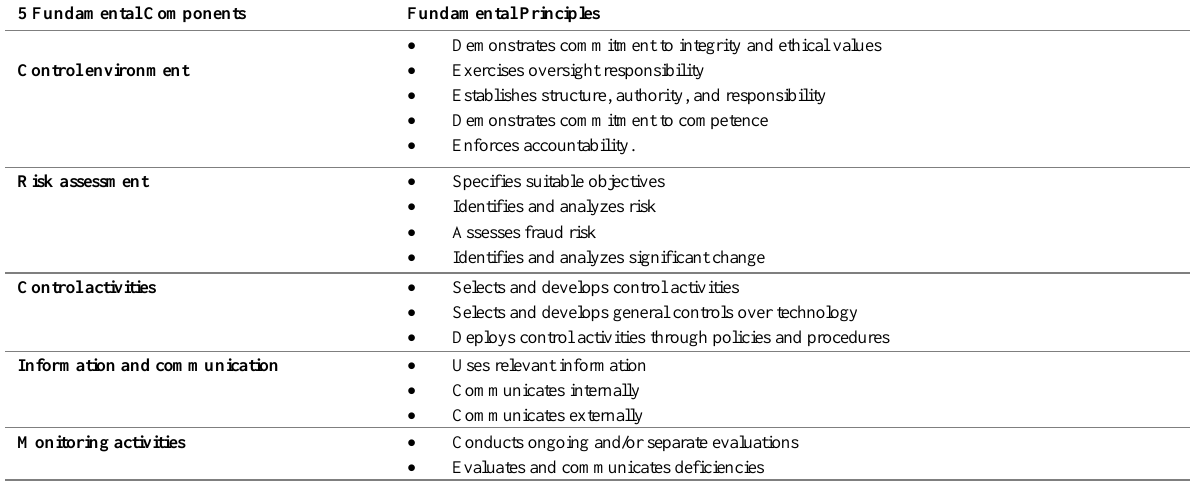
Table 1: Five Fundamental Components and Principles of COSO-Based Integrated IC